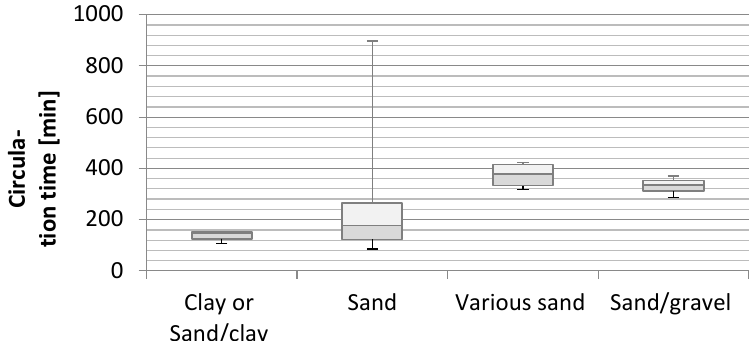
Figure 8. Drilling fluid circulation time in specific fractions.